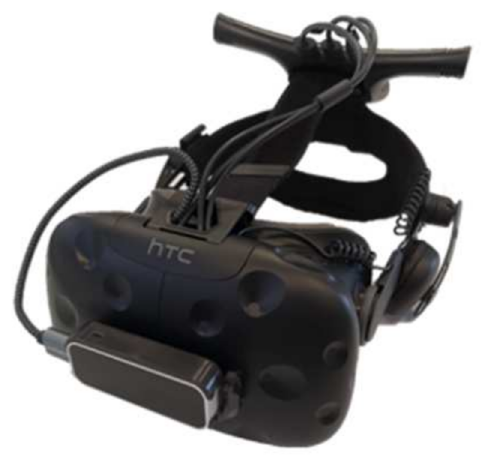
Figure 1. HTC VIVE glasses with Leap